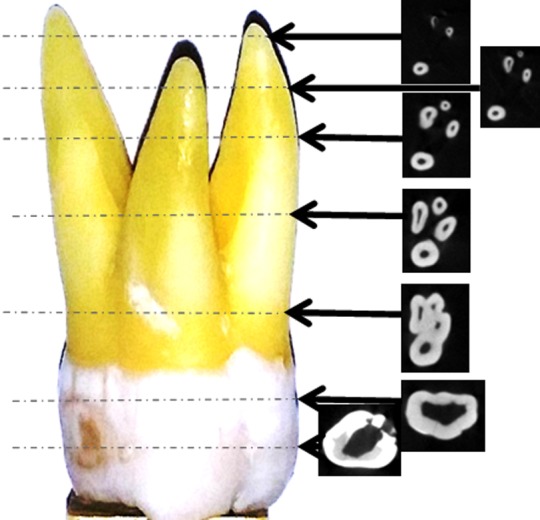
Series of CBCT images of a rare (four rooted) maxillary 1st molar representing the internal anatomy and anatomical variations at various levels.